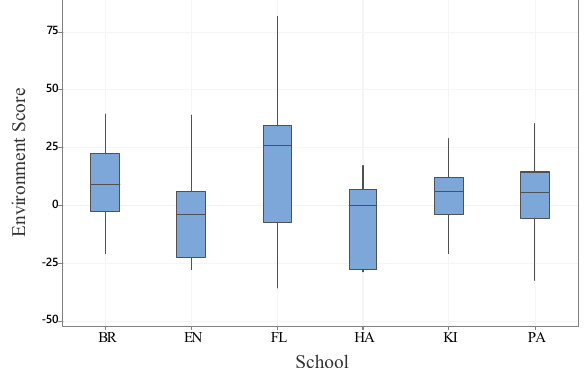
Fig. 5 Environment Score (words per minute) for each school site. The centre line of each boxplot represents the data median, and the bounds of the box show the interquartile range. The whiskers represent the bottom 25% and top 25% of the data